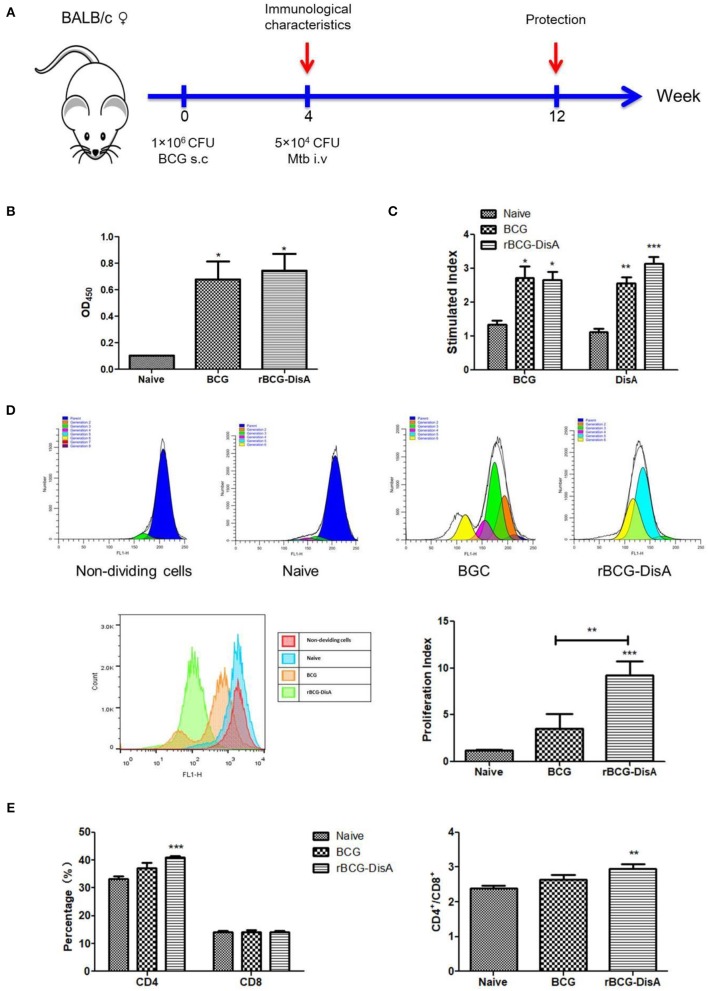
Humoral and cellular immune responses of rBCG-DisA-immunized mice. (A) The immunization and Mtb challenging scheme. Female BALB/c mice were subcutaneously (s.c.) immunized with 1 × 106 CFU BCG and rBCG-DisA, respectively, and PBS was used as negative control. At the fourth week after immunization, a group of three mice were sacrificed to determine immunological characteristics. At the same time, three mice were challenged intravenously (i.v) with 5 × 104 CFU virulent Mtb H37Rv strain, and mice injected s.c. with PBS (Naïve) were used as control groups. Eight weeks post-challenge, mice were sacrificed to detect immunological characteristics. (B) Four weeks after immunization, sera (1:200) from different groups were collected and total IgG titers of anti-BCG proteins were detected using ELISA. (C) Splenic lymphocyte proliferation was assayed using MTS agent after stimulating with BCG and DisA protein, respectively, for 72 h. (D) Splenic lymphocyte proliferation was determined using CFSE agent after stimulating with BCG proteins (25 μg/mL) for 7 days, and detected by flow cytometry. (E) Percentages of CD4+ and CD8+ T cells of splenic lymphocytes from each group, and the ratios of CD4/CD8 were calculated as shown. *P < 0.05, **P < 0.01, ***P < 0.001.